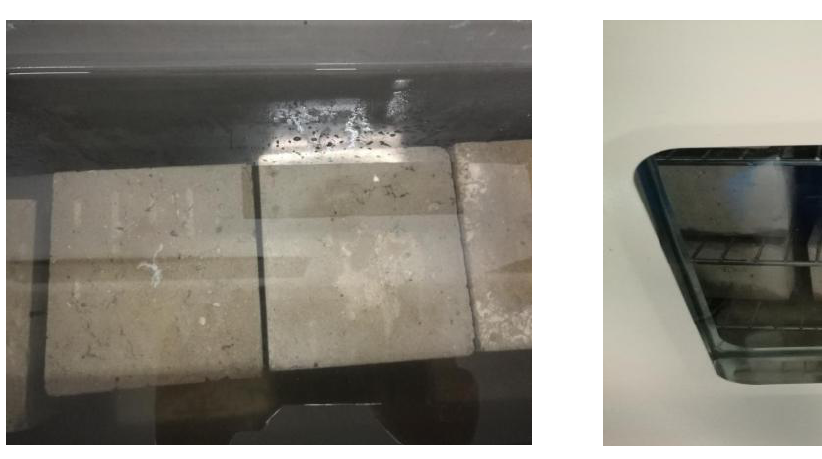
Figure 2. Wet-dry cycle test flow.